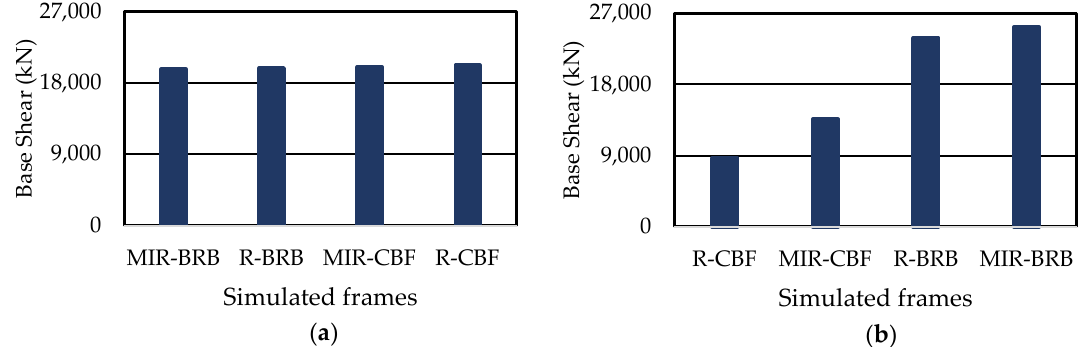
Figure 8. Average base shear comparison of ( a ) 10-story frames and ( b ) 15-story frames.